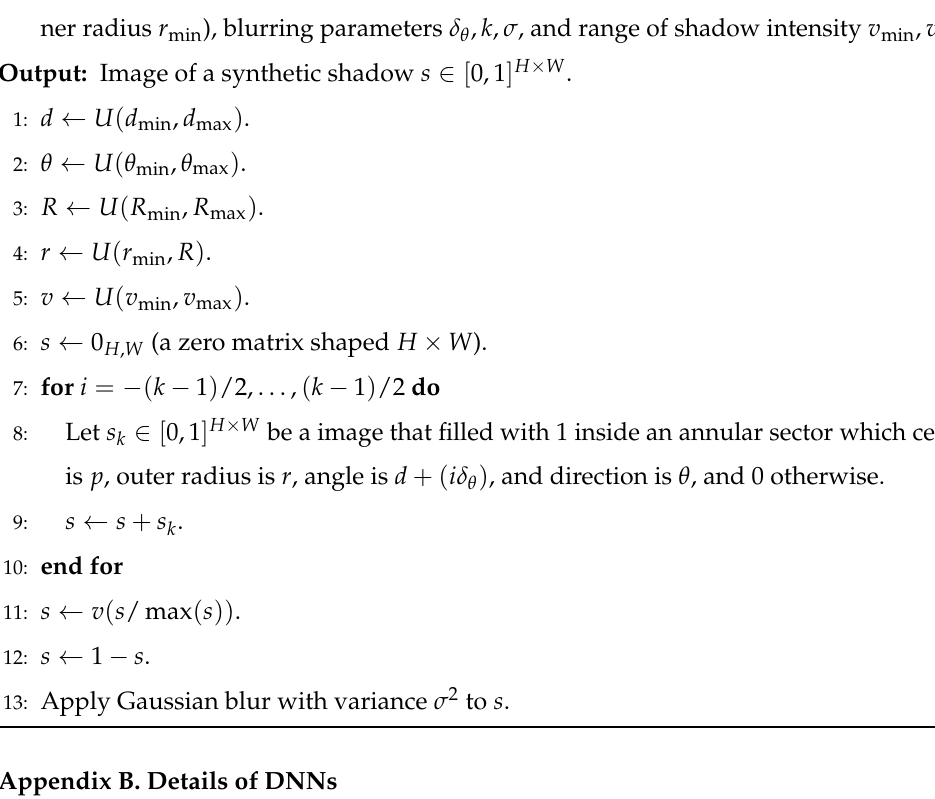
Algorithm A1 Generation of annular sector shaped synthetic shadows. A function U ( draws a sample from a uniform distribution.